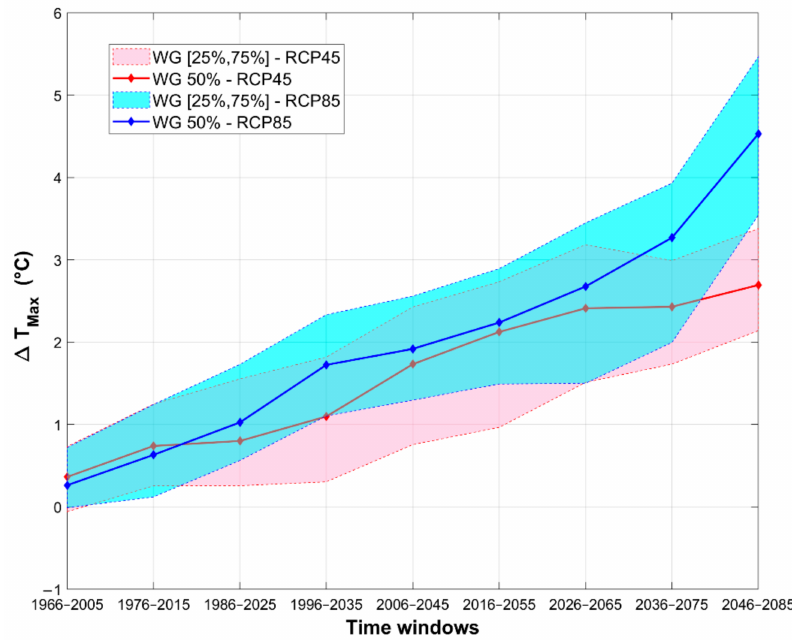
Figure 5. Factors of change for T Max,k at cell 101—prediction interval 25–75%.